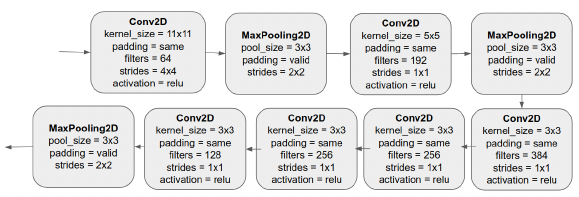
Figure 2. Feature extractor for the MM model shown in Figure 1.